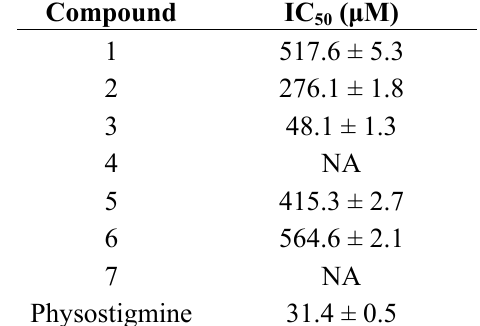
values) of the isolated 50